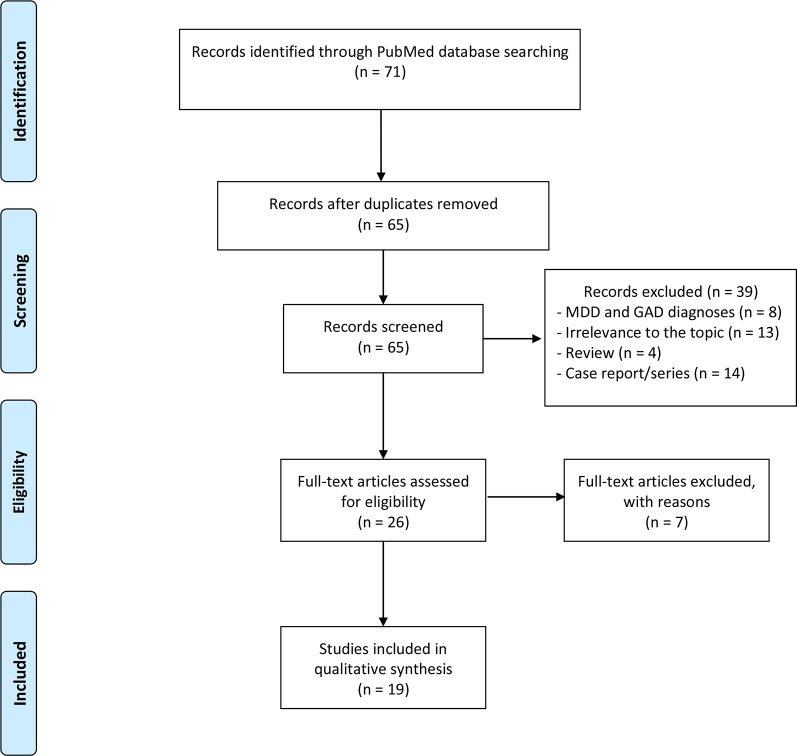
Flow diagram of the literature selection process.